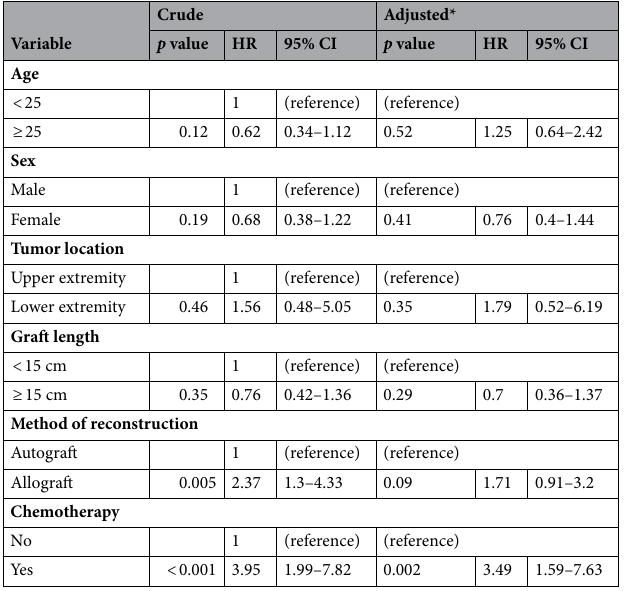
Table 3. Prognostic factors for failure of biological reconstruction. HR Hazard ratio, CI confidence interval. *Adjusted for age, sex, tumor location, graft length, method of reconstruction, and the use of chemotherapy.